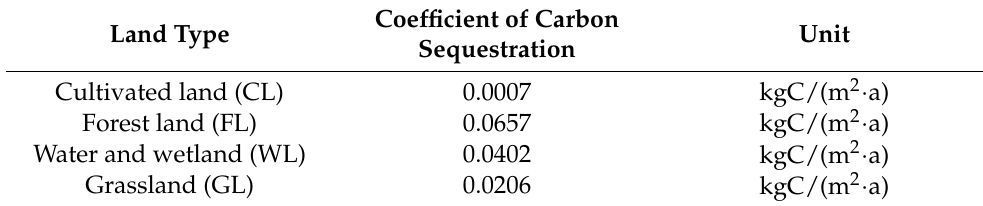
Table 2. Carbon sequestration coefficient of each land use compartment in the territorial